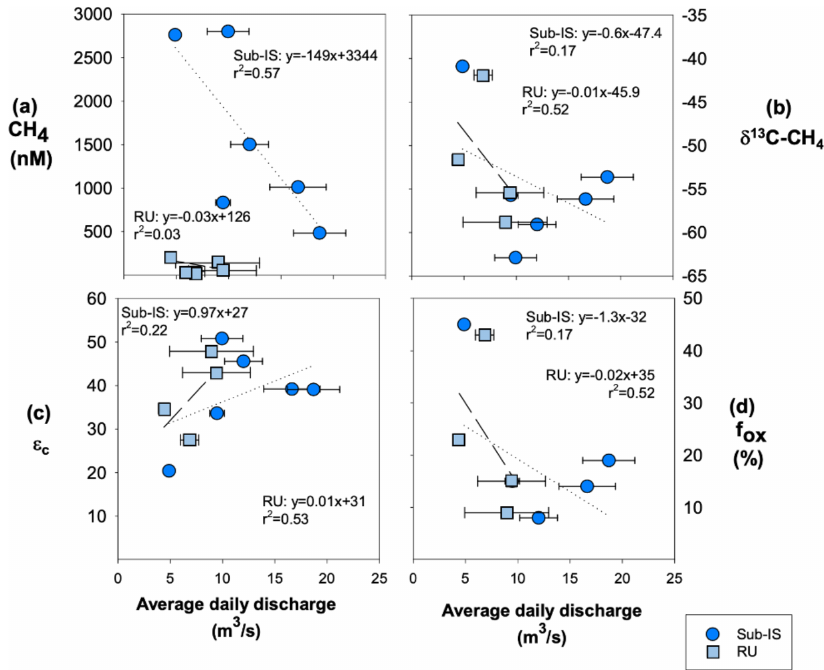
Figure 5. Relationships between average daily discharge and CH 4 dynamics including (a) CH 4 concentrations, (b) δ 13 C-CH 4 , (c) f ox , and (d) ε c for sub-Isunnguata (sub-IS) and Russell (RU) samples. Regressions are shown by dotted lines for Isunnguata and dashed lines for Russell samples. Horizontal error bars represent the standard deviation of average daily discharge for days samples were collected and are smaller than symbols for some data